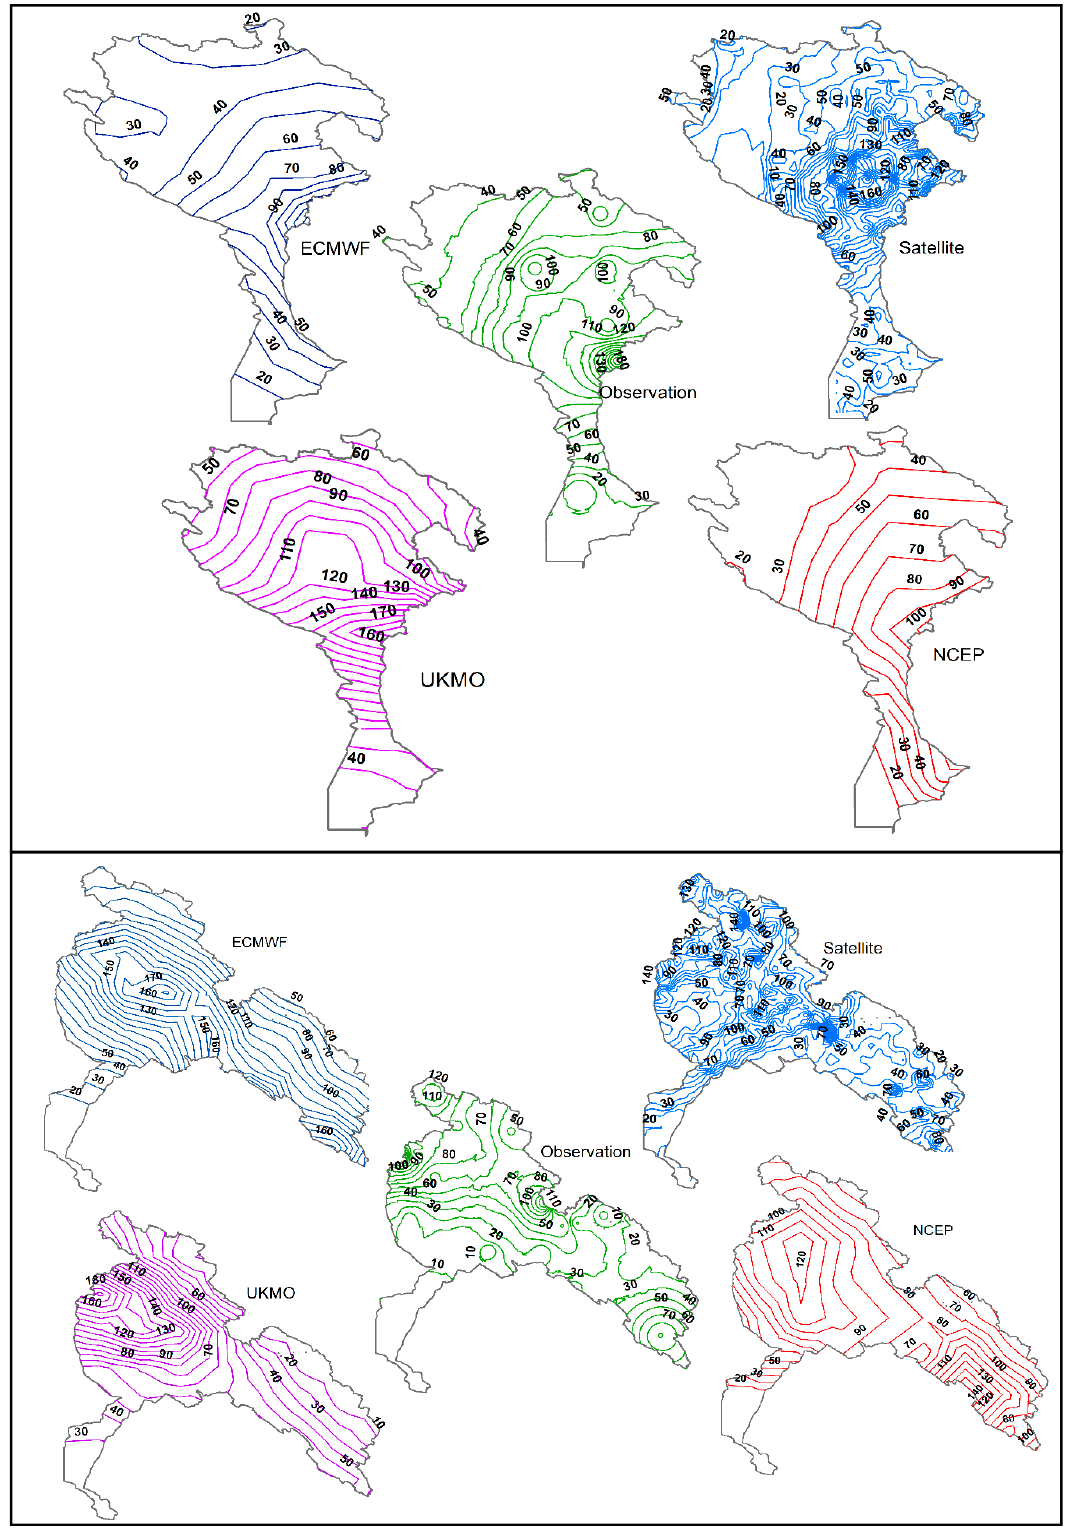
Figure 5. Isohyet contours in the Karkheh ( top ) and Karun ( bottom ) Basins during the second flood event.